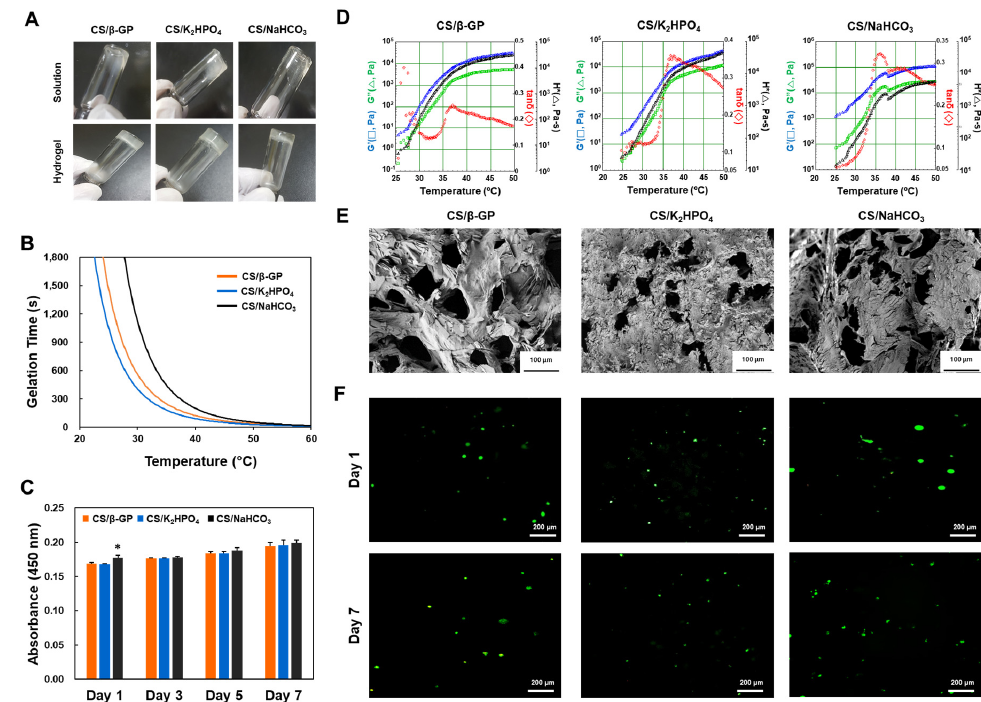
Figure 2. Influence of gelling agents on chitosan hydrogels. ( A ) Representative images of chitosan sol-gel transitions induced by temperature. ( B ) Gelation time of chitosan hydrogels in the presence of di ff erent gelling agents, as estimated by the test tube inversion method. ( C ) Cell viability of PDLSCs via indirect culture using the WST-1 assay. Error bars indicate standard deviation (n = 5 for each group). * Represents statistically significant di ff erences compared to the control group ( p < 0.05). ( D ) Rheological analysis of chitosan hydrogels, with temperature-dependent changes in the storage modulus (G (cid:48) ) and loss modulus (G”) from 25 ◦ C to 50 ◦ C. ( E ) SEM images of the surface of the chitosan hydrogel. Samples were prepared by dipping chitosan gels in distilled water at 37 ◦ C for 1 day, followed by lyophilization overnight. ( F ) Live and dead assay results of PDLSCs encapsulated in chitosan hydrogels (green: live cells; red: dead cells). PDLSCs, periodontal ligament stem cells; SEM, scanning electron microscopy; WST, water soluble tetrazolium